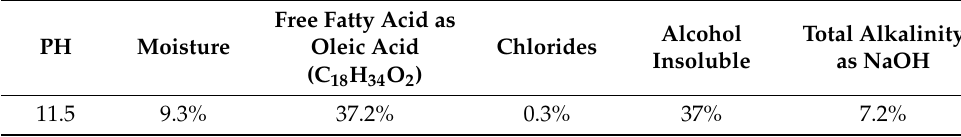
Table 1. Chemical classification of